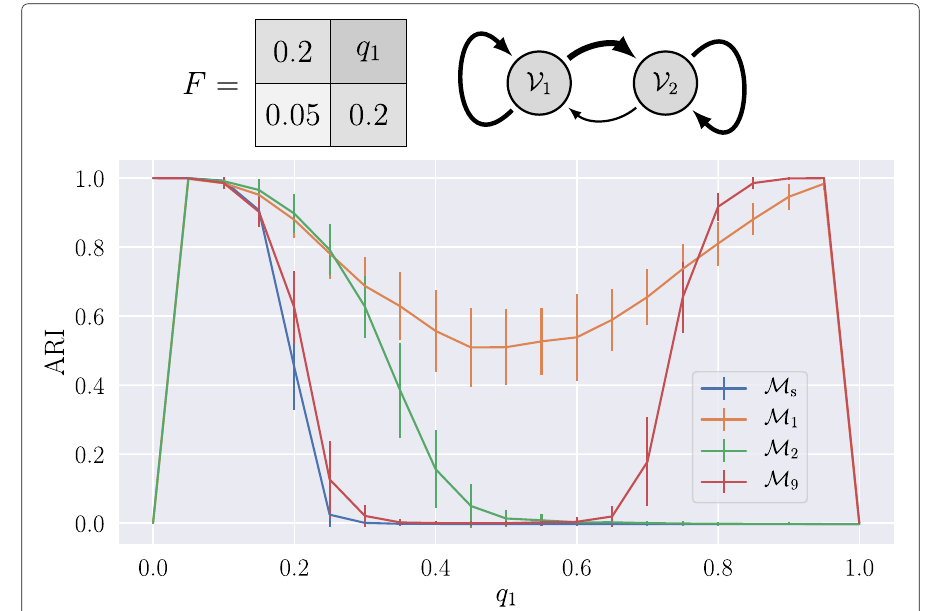
Fig. 6 Top: DSBM parameters for Example 2 Experiment 1. Left panel, the connection matrix for this model (Eq. 5). Right panel, a schematic diagram of the structure: larger arrows represent connections with higher probabilities. Bottom: Performance on this benchmark using structural MAMs. We compare with standard symmetrization M s . We perform 100 repeats, and error bars are one sample standard